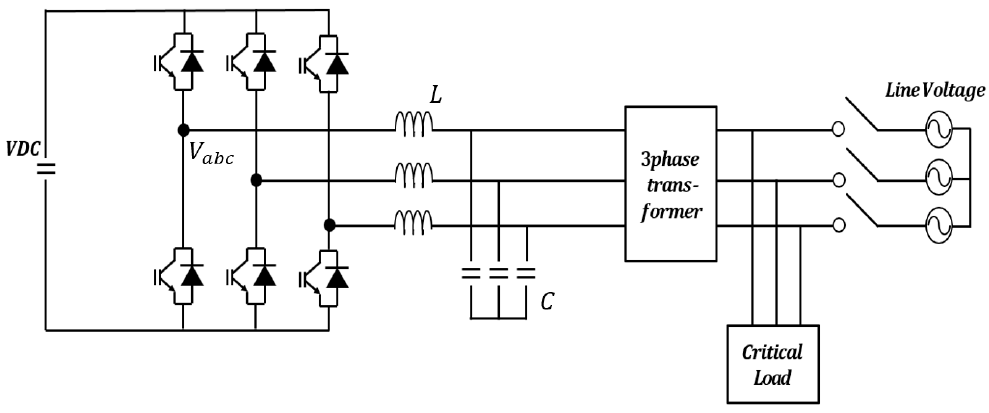
Figure 3. Alternating current (AC) microgrid inverter circuit.